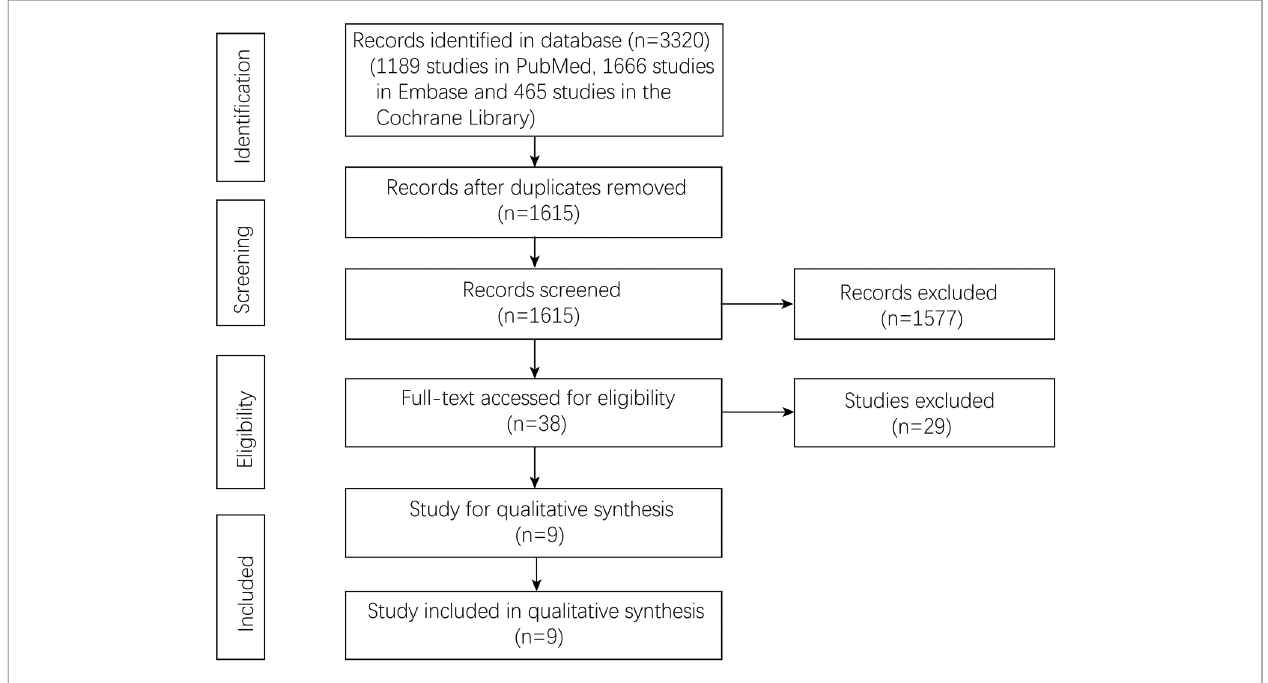
FIGURE 1 | Flowchart of study selection.